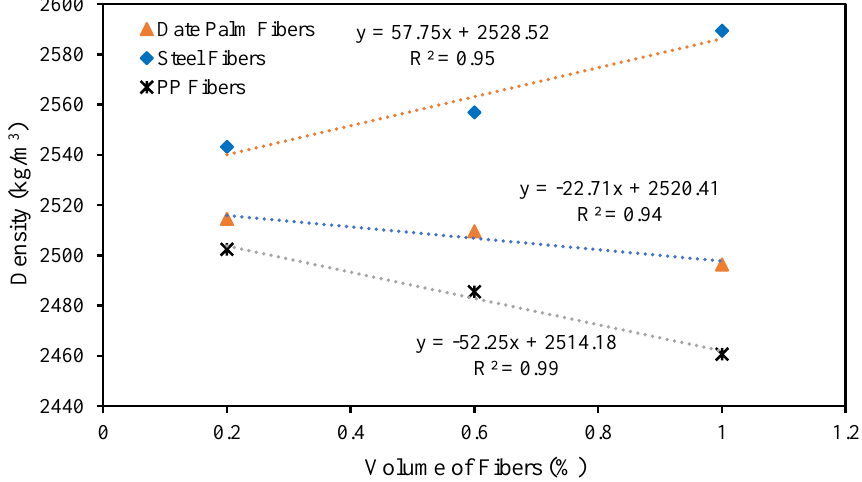
Figure 11. Relationship between the density and volume fractions of different fibers.